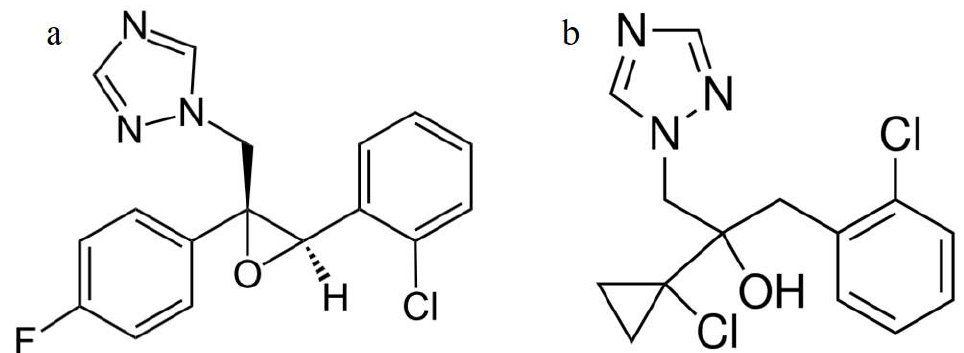
Figure 1. Chemical structures of Eepoxiconazole (EPX) ( a ) and prothioconazole (PTC) ( b ). EPX is characterized by acute oral, dermal, and inhalation toxicity. It was adminis- trated in a feed study to male and female mice, and both subsequently displayed signifi- cant increasing trends in liver adenomas, carcinomas and adenomas, and carcinomas combined [4]. Schneider et al. observed reduced estrogen levels after EPX treatment in rats [5]. The results obtained by Taxvig indicate that EPX is primarily fetotoxic, and sec- ondly alters sex hormone levels in the dams, but not in the fetus during the developmental stages. The effects on reproductive development after perinatal exposure strongly indicate that one of the main mechanisms responsible is disturbance of key enzymes involved in steroid hormones synthesis [6]. EPX may also antagonize the androgen receptor and in- hibit testosterone formation in vitro [7]. PTC mainly disrupts the endocrine system and has the potential to affect the human reproductive system [8]. Several studies have shown that PTC reduces cell proliferation (GH3 tumor cells) and inhibits the basal activity of the aryl hydrocarbon receptor (AhR) [9]. In vitro tests have shown that peripheral blood lym- phocyte proliferation in cattle was almost completely inhibited within 48 h after exposure (30 µg/mL) to PTC [10]. Serum albumins (SAs) are the most abundant proteins in the blood system of a vari- ety of organisms. Being the major macromolecules (60% of total protein, 3.5–5 g/dL) [11]